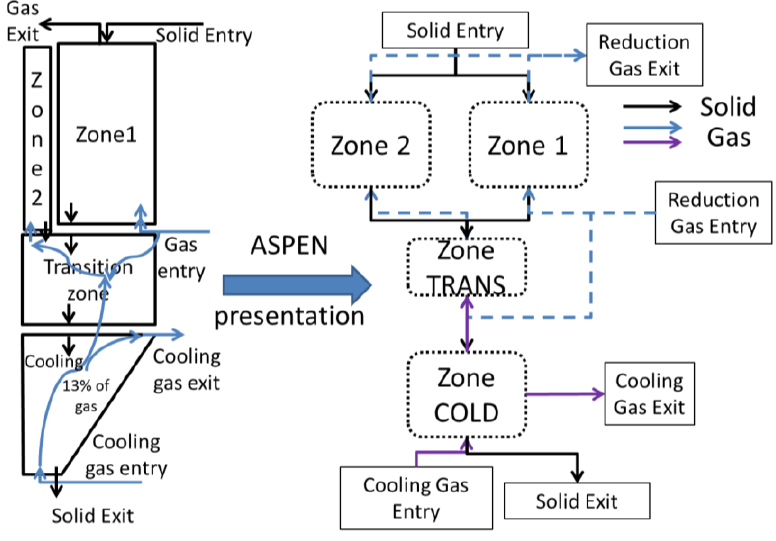
Figure 3. Sectioning of the shaft furnace for the Aspen Plus model.